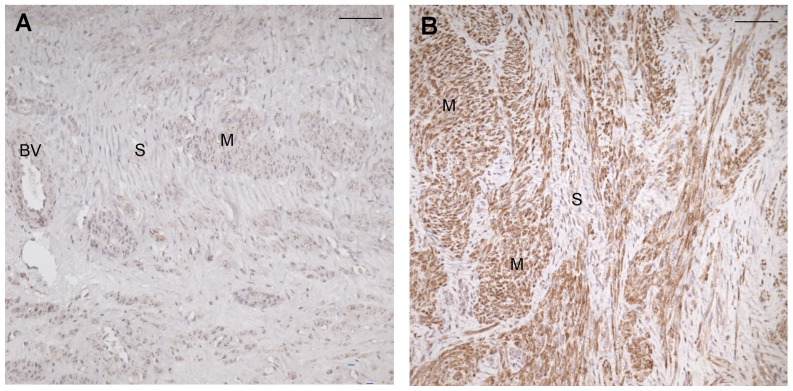
Immunohistochemical analysis of GSTM1 show low immunostaining in poor responder (A) compared with good responder (B) to mifepristone treatment.Muscle bundles (M) in good responders had higher accumaulation of GSTM1 protein than the stroma (S). Poor responders showed very low immunostaining for GSTM1 in muscle budle (M) and the smooth muscle cells of blood vessels (BV). The stroma (S) was almost negative. (Bar = 12 µ).